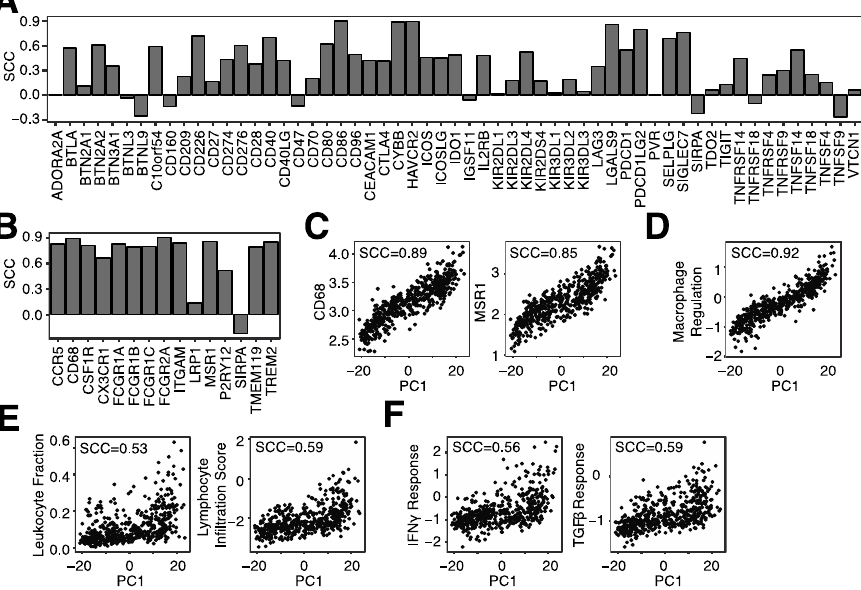
Figure 5. Microglia infiltration is associated with the mRNA expression of immune checkpoint genes and immune regulatory pathways. ( A ). Spearman correlation coefficient (SCC) between PC1 and the mRNA expression of several immune checkpoint genes. ( B ). SCC between PC1 and mRNA genes expressed in microglia. ( C ). SCC between PC1 and CD86 and MSR1 mRNA levels. ( D ). SCC between PC1 and a macrophage regulation score. ( E ). SCC between PC1 and leukocyte and lymphocyte infiltration. ( F ). SCC between PC1 and IFN γ response and TGF β response.